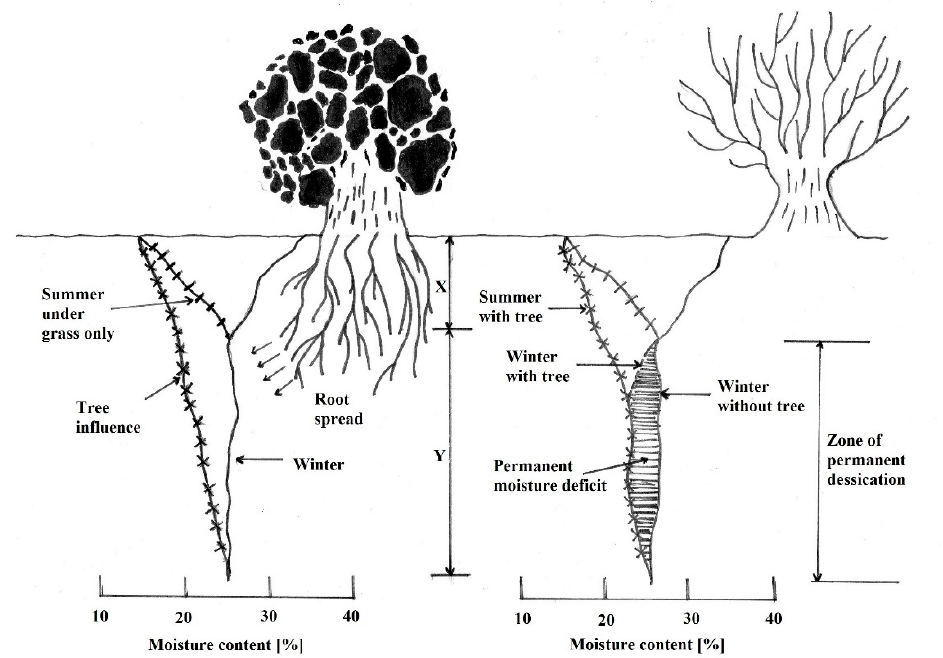
Figure 14. Changes in soil moisture content: tree influence (summer) on the left and tree influence (winter) on the right.